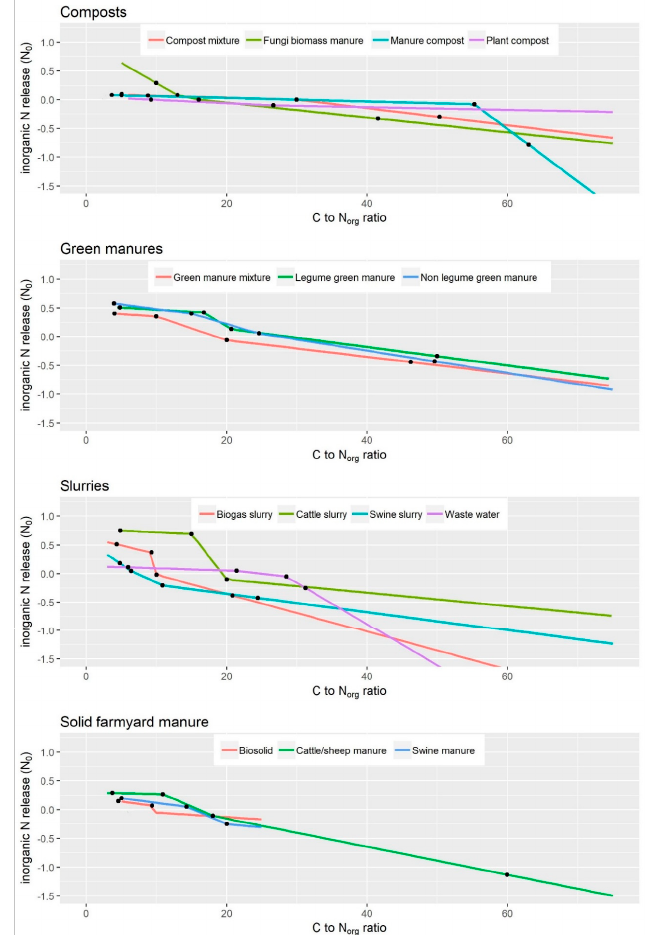
Figure 7. Dependency of potential inorganic N release within 150 days after organic fertilizer application on the fertilizer C to organic N ratio in different fertilizer classes.